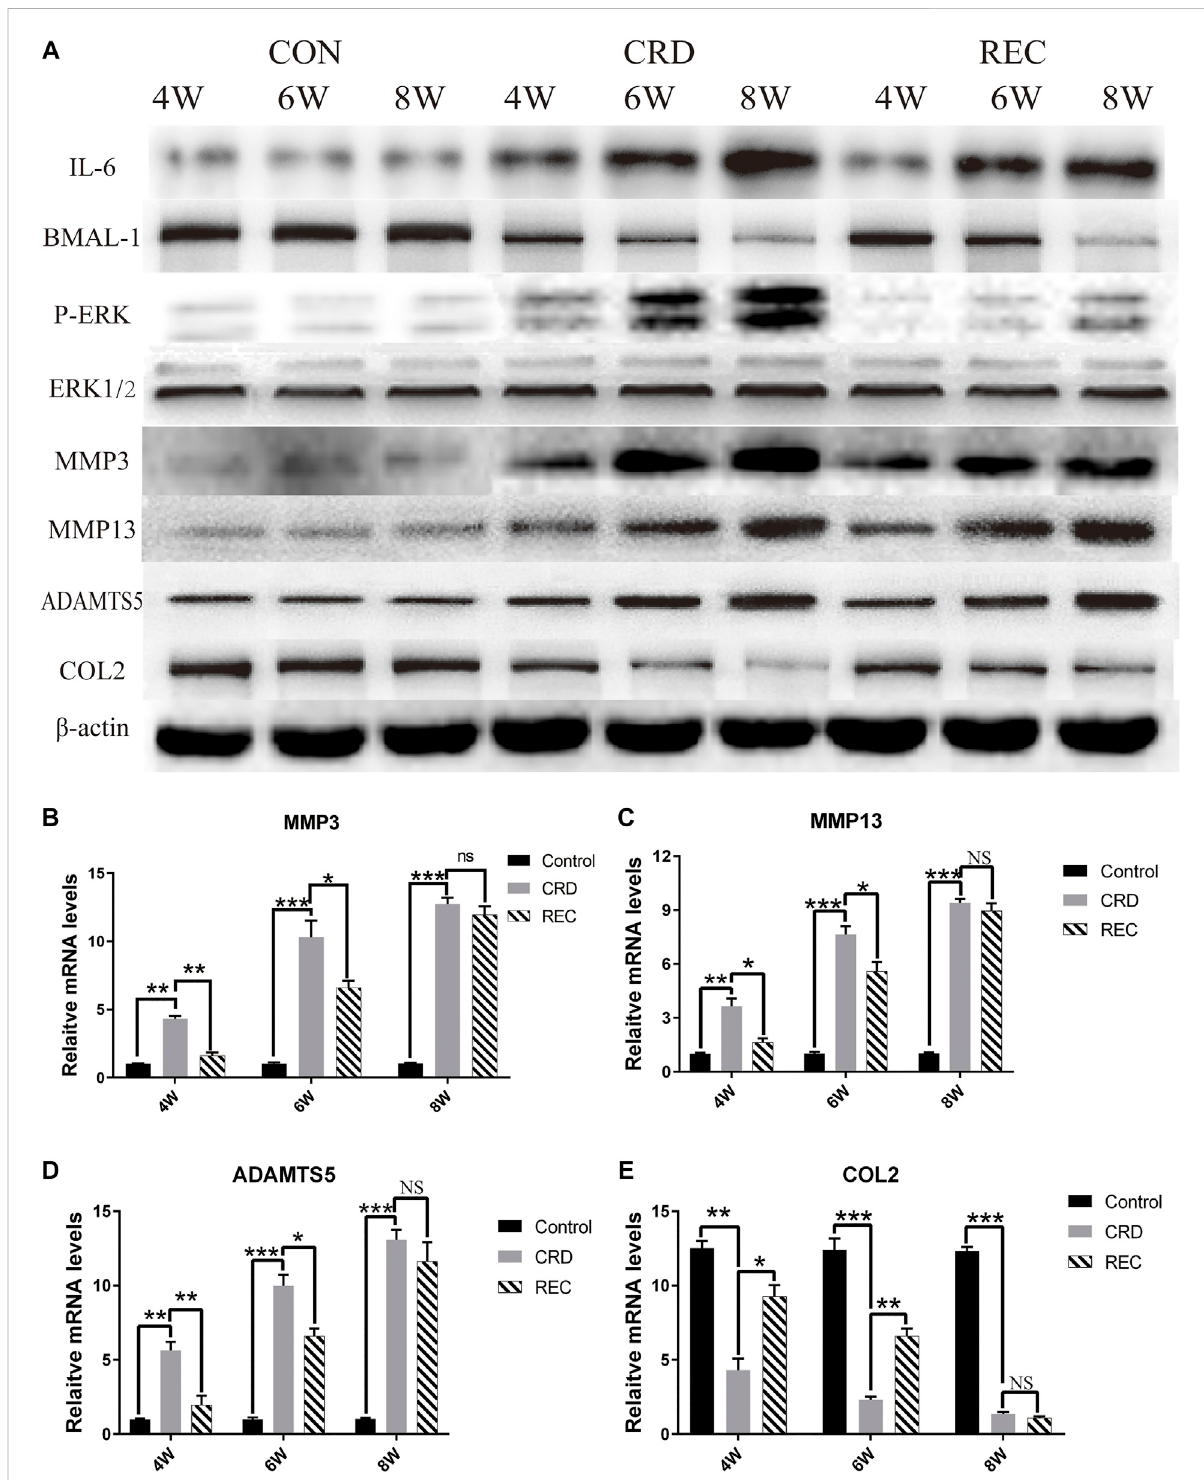
FIGURE 3 ExpressiontrendsforIL-6/P-ERK/BMAL-1/MMP3/MMP13/ADAMTS5/COL2intheCON,CRD,andRECgroups. (A) WesternblotresultsforIL-6/ P-ERK/BMAL-1/MMP3/MMP13/ADAMTS5/COL2. (B – E) RT-qPCR analysis of MMP3/MMP13/ADAMTS5/COL2. All experiments were performed in triplicate, and the results are expressed as the mean ± SD. * p < 0.05; ** p < 0.01, *** p < 0.005. NS, not signi fi